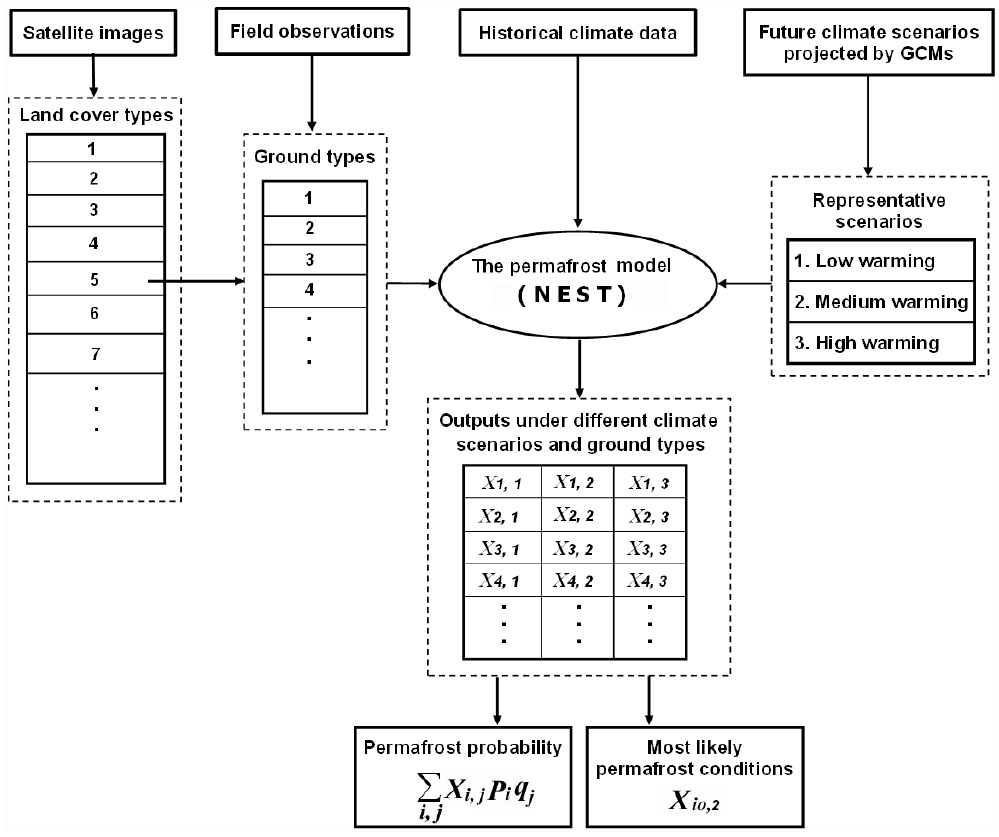
Figure 1. The scheme of the new permafrost mapping approach. A land cover map classified from satellite images is used to represent the general land conditions and to improve the spatial resolution. For each land cover type, the probability of different ground conditions is estimated based on field observations. A process-based permafrost model (NEST) was used to calculate the evolution of permafrost for each ground type under three representative climate change scenarios generated by general circulation models (GCMs). From the model outputs, the probability of permafrost occurrence and the most likely permafrost conditions are determined. In the above scheme, X i,j is the model output based on ground type i and climate scenario j . p i is the probability of ground type i , and q j is the probability of climate scenario j . io is the most probable ground